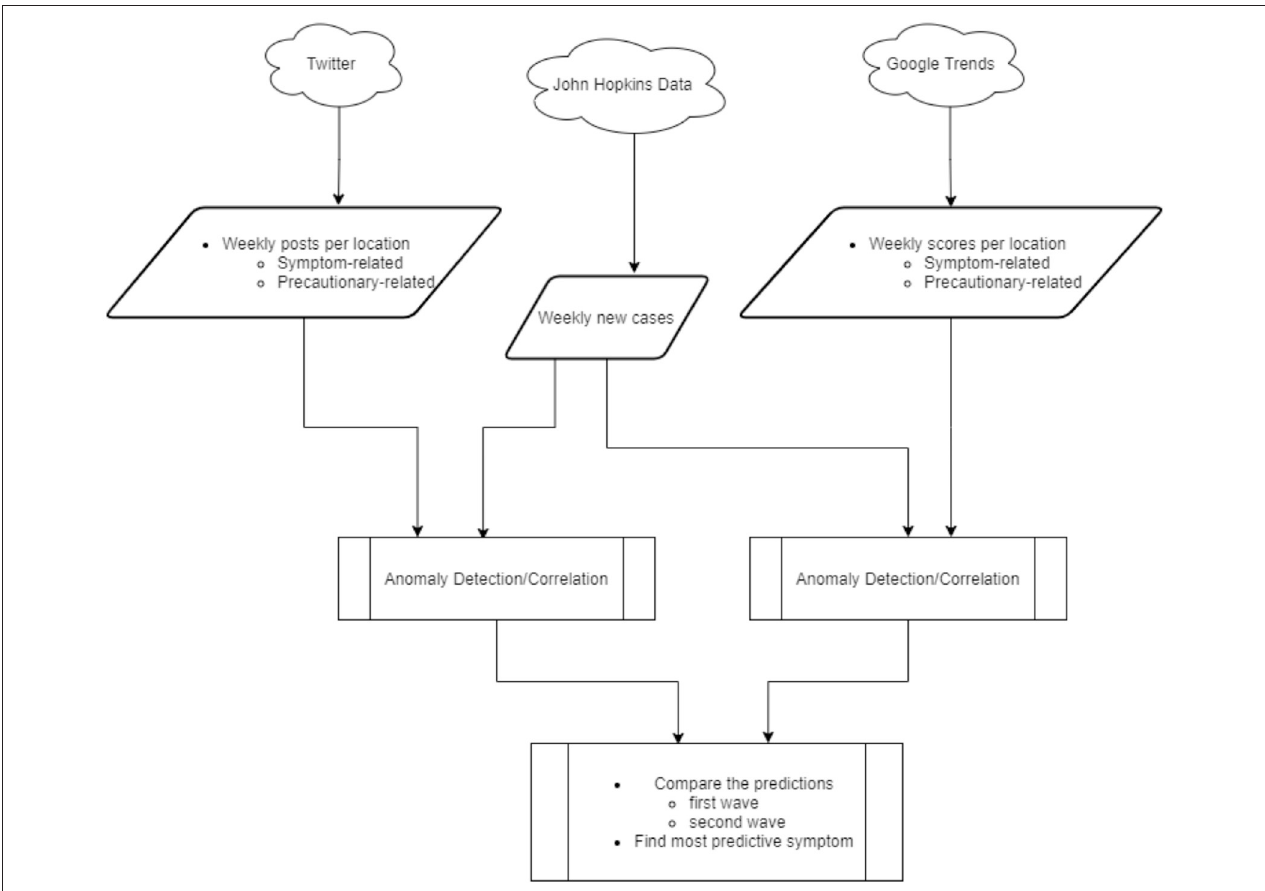
FIGURE 1 | Overall